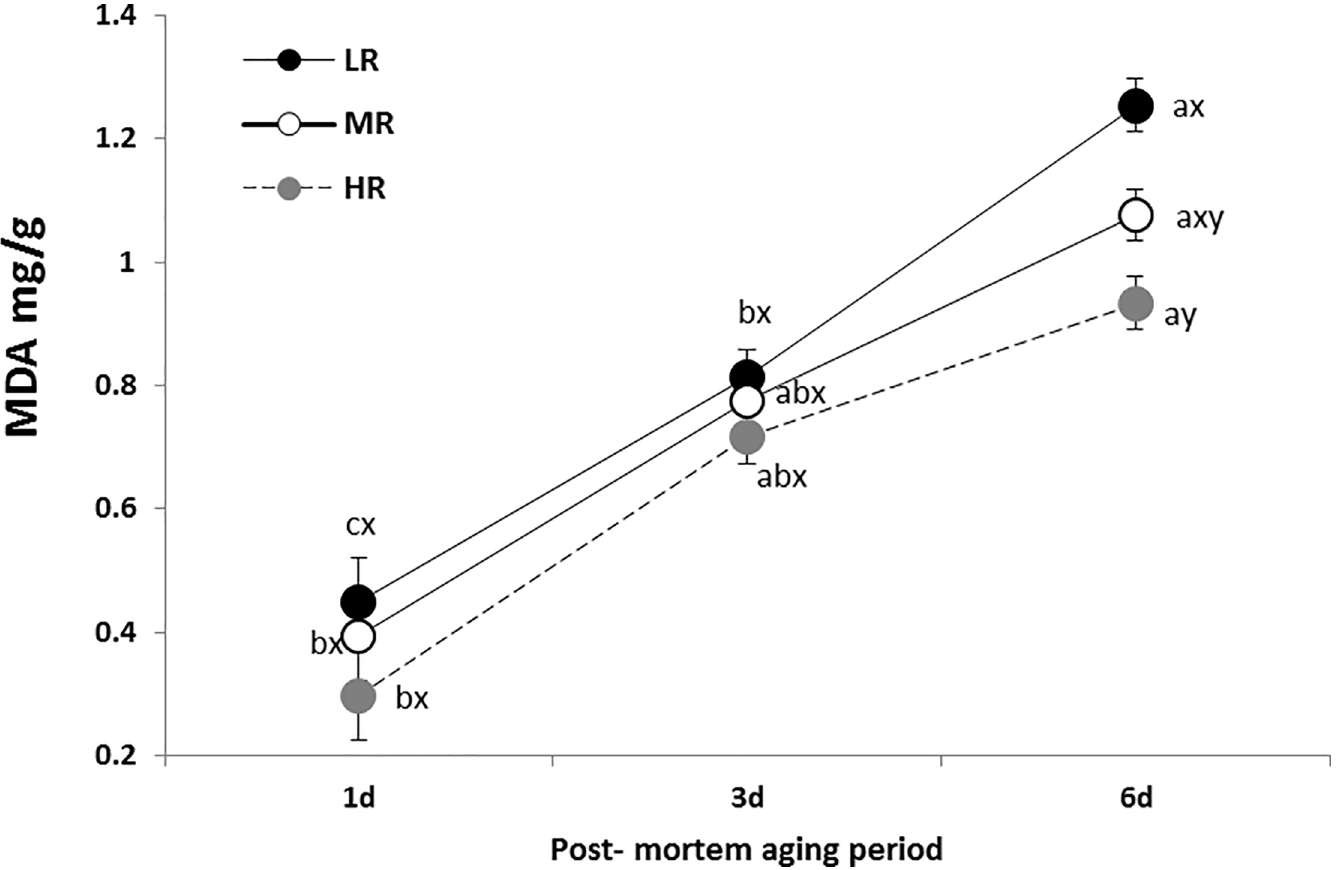
Fig 1. Effect of dietary n -6: n -3PUFA ratios on lipid oxidation of longissimusdorsi in goats. LR: low n -6: n -3 PUFA ratio (2.27:1); MR: medium n -6: n -3 PUFA ratio (5.01:1); HR: high n -6: n -3 PUFA ratio (10.38:1). Vertical bars are standard error. x and y denote significant difference within day of post-mortem; a, b and c denote significant difference between days of